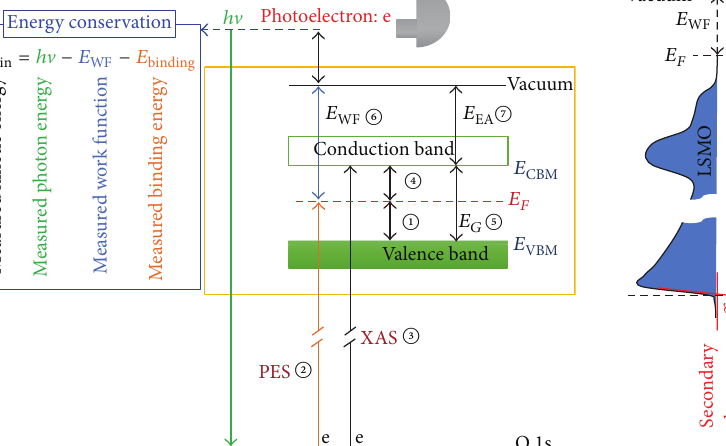
Figure 2: A simplified schematic diagram of Fermi alignment in a